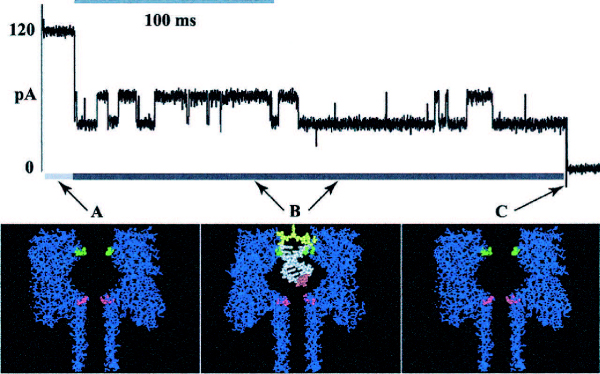
Examination of DNA duplex ends using a voltage-pulse routine. Source [6]